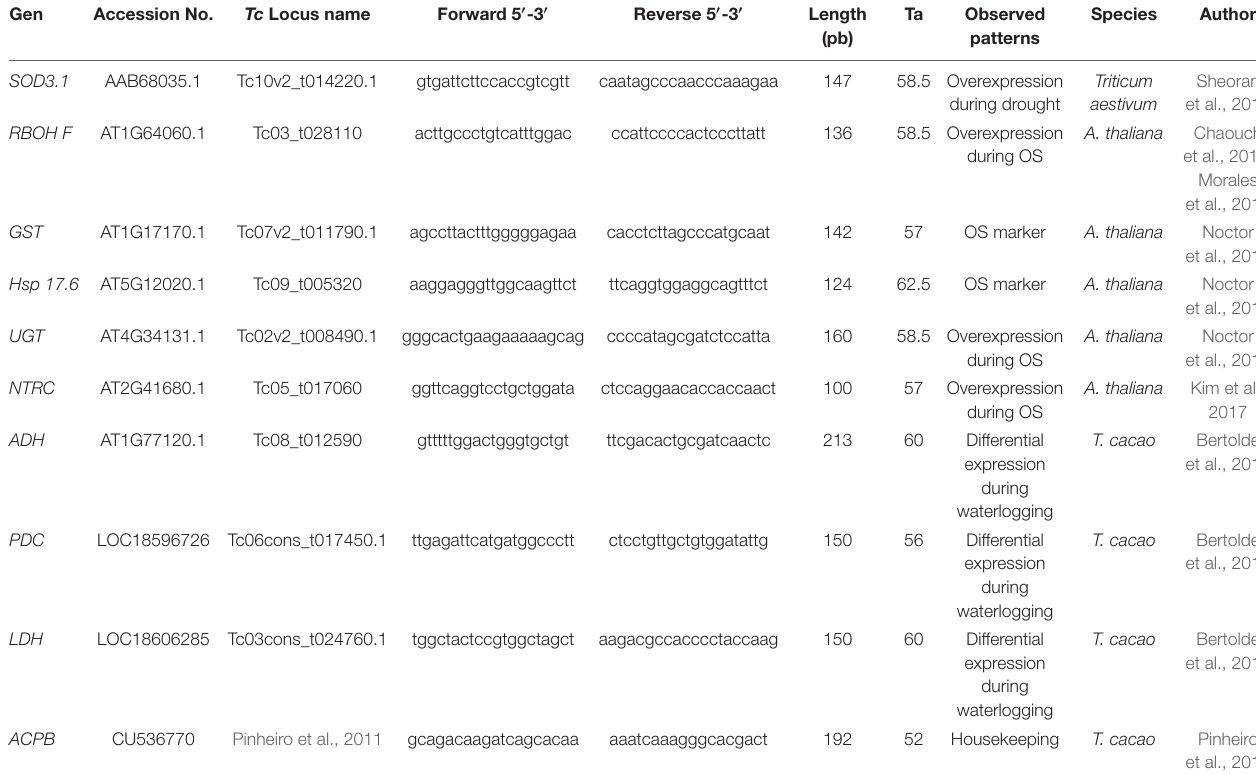
TABLE 2 | Cacao orthologous genes related to the antioxidant system evaluated in this study. The sources of selected genes, expression patterns found in previous studies and primer sequences designed for RT-qPCR analysis are detailed. Gen Accession